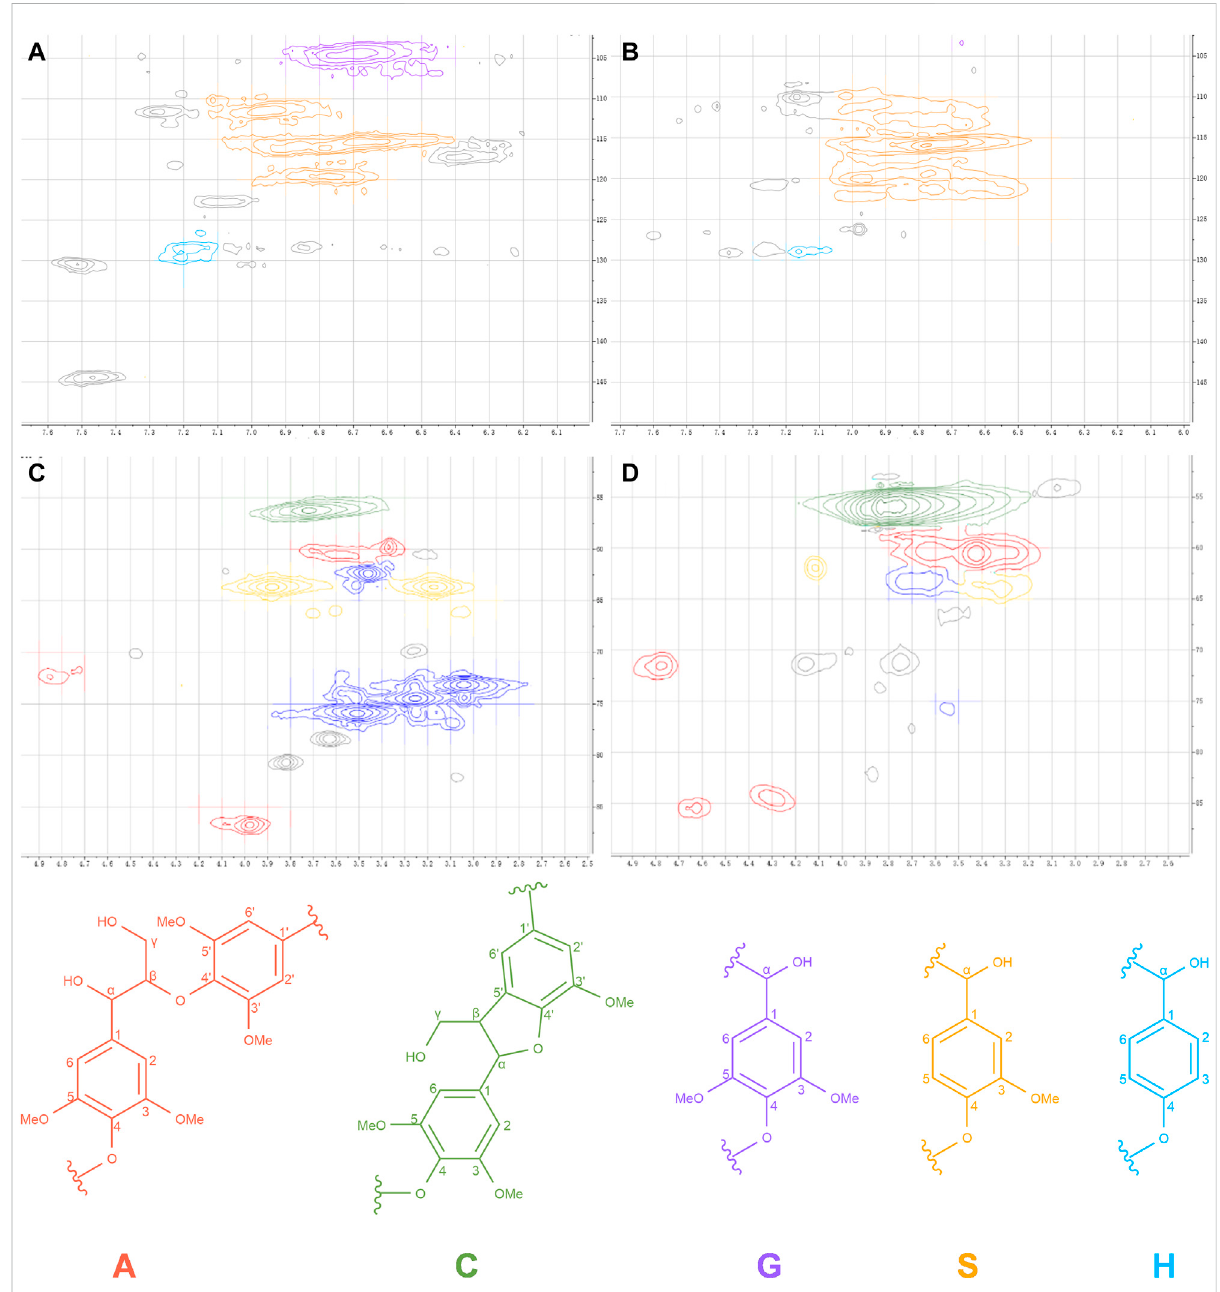
FIGURE 8 2D-NMR spectra for lignin. (A,C) represent the aliphatic-oxygenated 1 H − 13 C correlations ( δ H/ δ C 2.5 – 6.0/50 – 90 ppm region) giving information on lignin side-chain interunit linkages; (C,D) represent the aromatic/ole fi nic 1 H − 13 C correlations ( δ H/ δ C 6.0 – 8.0/100 – 150 ppm region) giving information on lignin aromatic